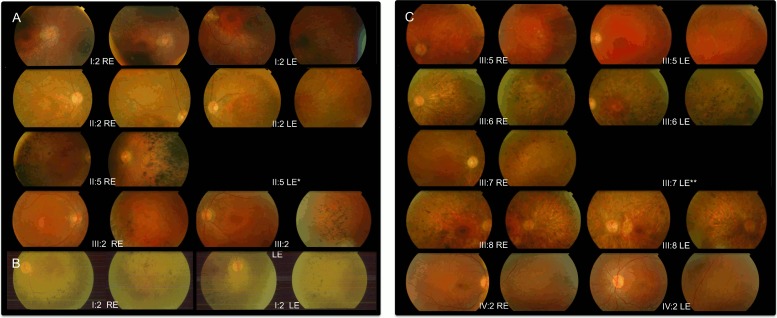
Fundus Images: Each patient presents two fundus images per eye.A) Family RP-0030, B) Family RP-0576, C) Family RP-0711. *Fundus image not available. **Enucleation of the LE due to glioblastoma. RE = Right eye. LE = Left eye.